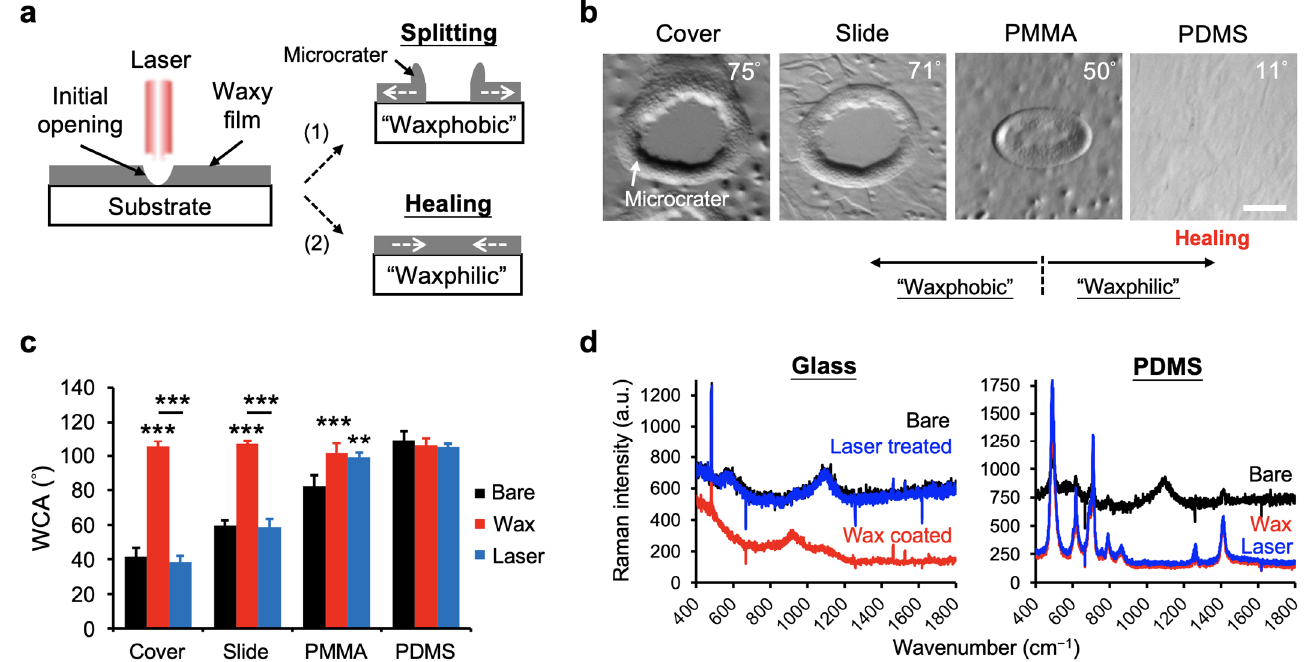
Figure 4. Laser direct writing on waxy films coated on different substrates. ( a ) Illustration showing two waxy patterns carried by laser writing—splitting and healing based on “waxphobic” and “waxphilic” substrates, respectively. ( b ) Micrographs showing the representative wax patterns formed by a 0.13 J/mm 2 CO 2 laser on different substrates. Scale bar = 50 μ m. ( c ) Comparison of WCA on different substrates during no treatment (bare), and treatments with a waxy film coating (Wax) and laser writing (Laser). ( d ) Raman spectra of the cover glass and PDMS substrates during the three different treatments. Data represent the mean ± SD, n = 4~6. ** p < 0.01 and *** p < 0.001.